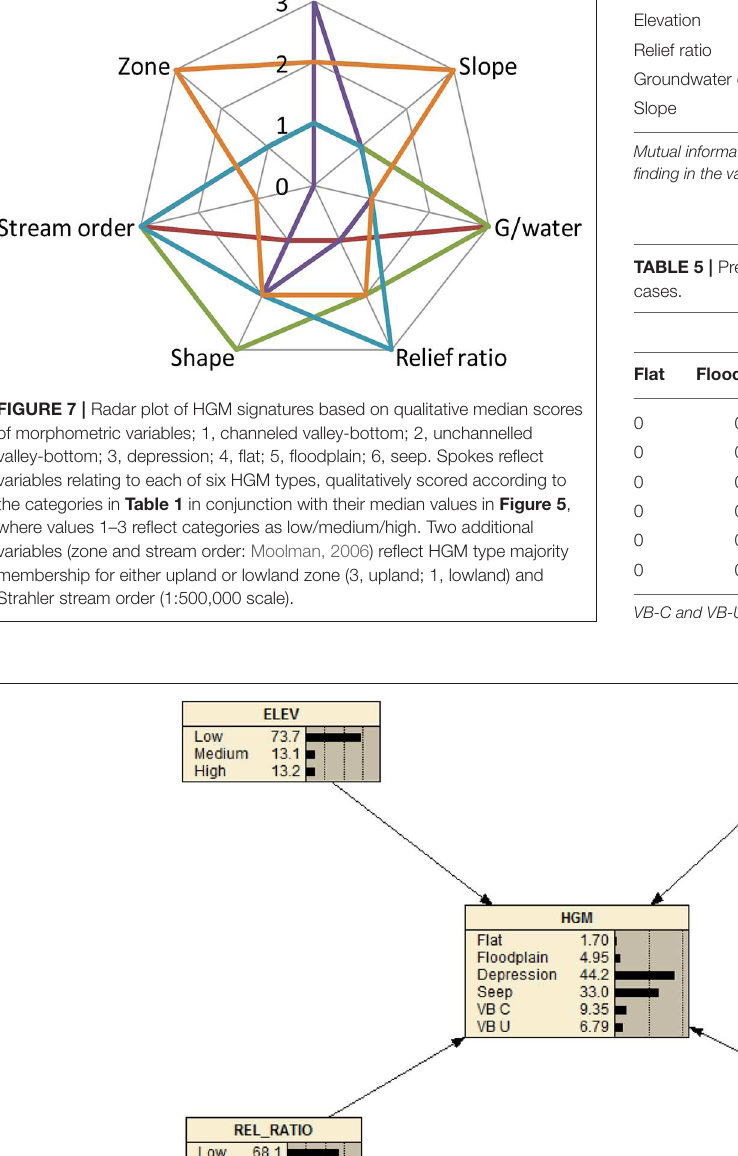
Frontiers in Environmental Science |